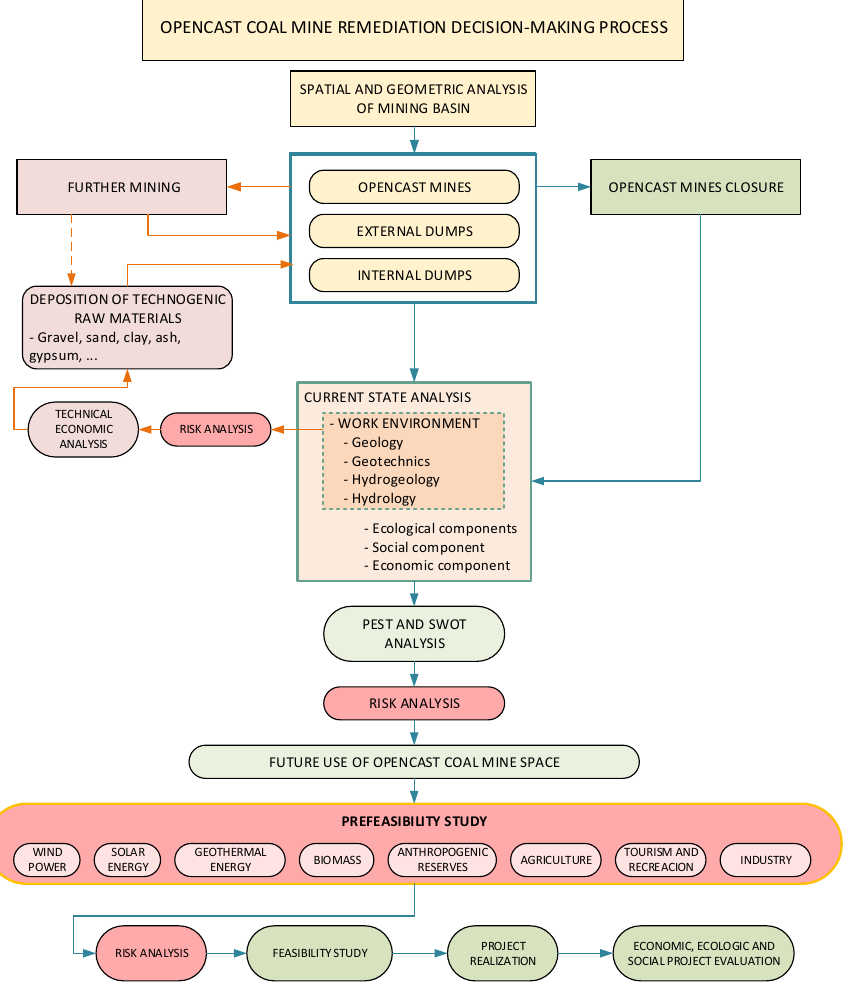
Figure 1. The process of remediation with possible use of opencast closed mine space in coal ba- sins.